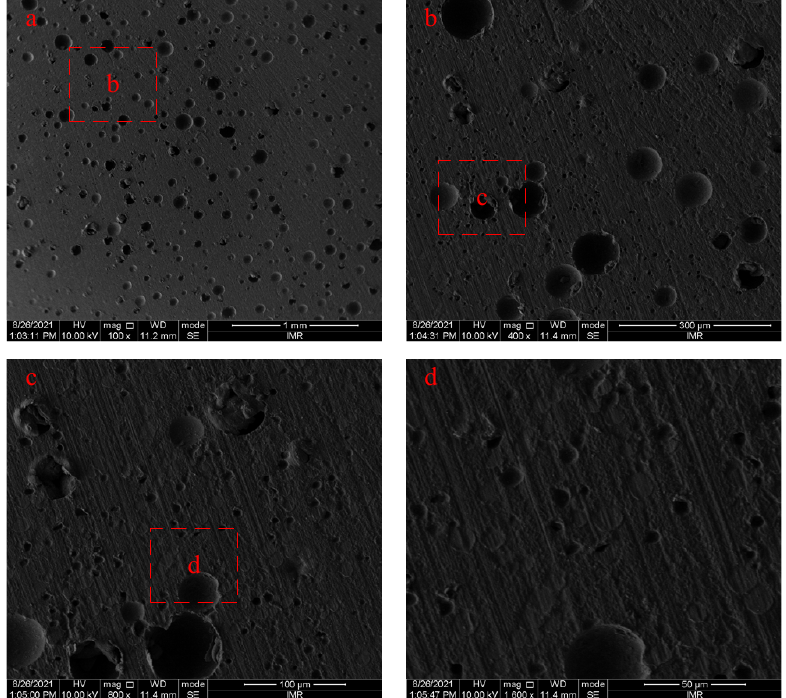
Figure 9. Microscopic morphology of the reinforced Al/PTFE specimen.